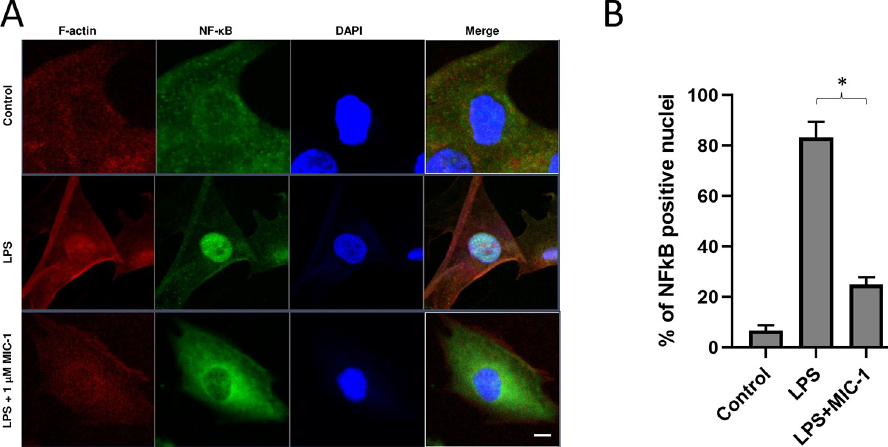
Fig 5. Moringa isothiocyanate-1 (MIC-1) inhibited the NF- κ B nuclear translocation in skeletal muscle cells. The effects of MIC-1 on lipopolysaccharide (LPS)-induced nuclear translocation of NF- κ B in C2C12 muscle cells. Treatments: untreated control, LPS (10 μ g/mL), and LPS + 1 μ M MIC-1 for 1 h. The NF- κ B (p65) location was observed using FITC-anti-NF- κ B p65 antibody, phalloidin-actin (F-actin; cytoskeleton), and DAPI (nuclei). (A) Representative pictures taken by using confocal microscopy. Scale bar: 20 μ m. (B) The percentage of nucleic positive cells to NF- κ B (p65). Data are represented as mean ± SD (n = 6, from three independent experiments). � P < 0.05, obtained by t-test when compared to LPS-treated